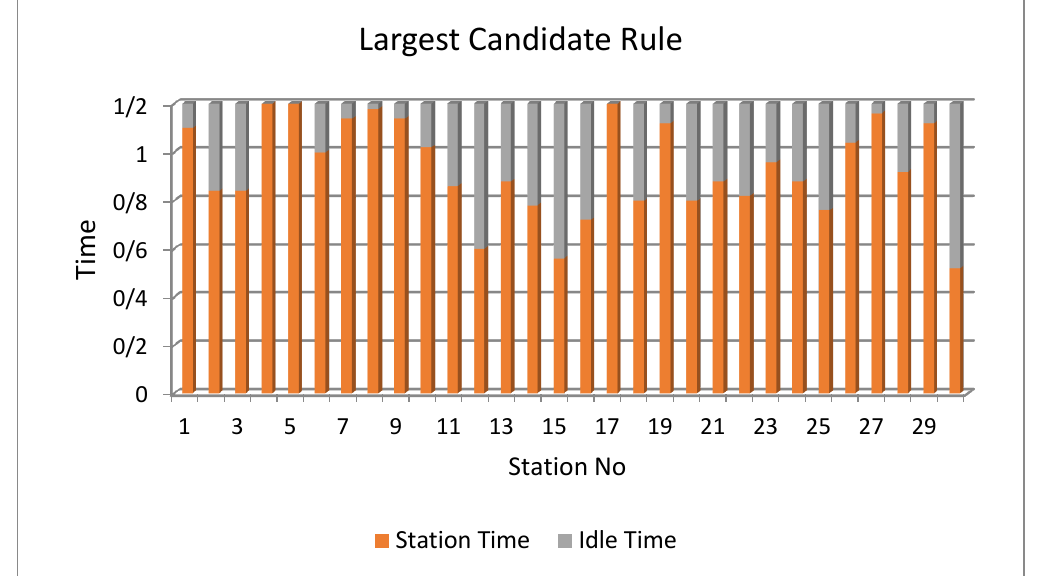
Figure 7. Service time and idle time of